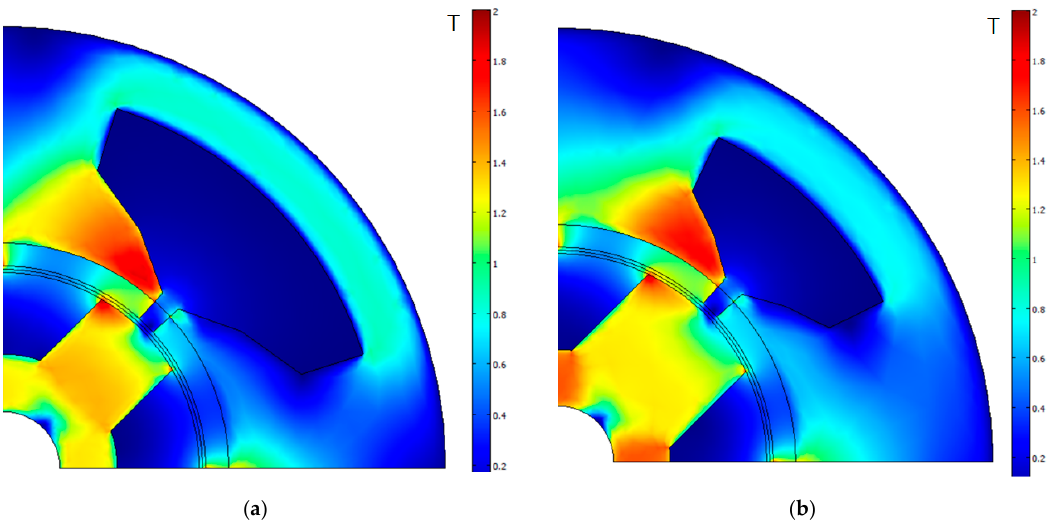
Figure 6. Magnetic flux density field when the rotor teeth are over the stator slot: ( a ) Before optimization; ( b ) after optimization.